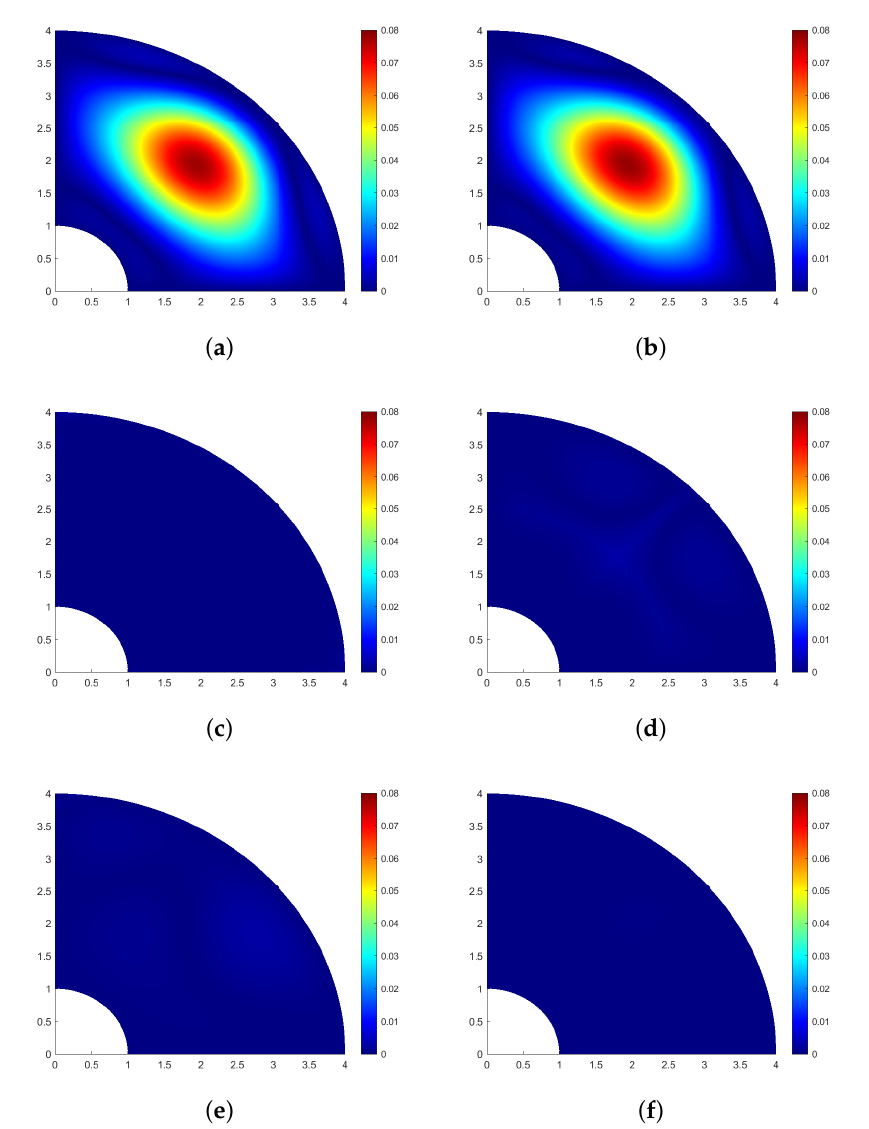
Figure 9. Absolute errors of IGA-C with different collocation schemes after twice h − refinements ( p = 3): ( a ) Greville. ( b ) Demko. ( c ) SC. ( d ) CG. ( e ) ASC. ( f )